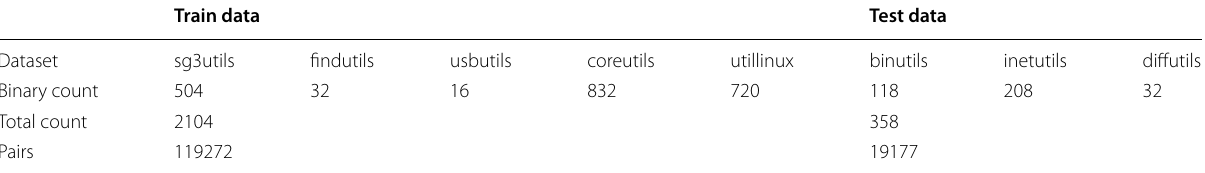
Table 6 A dataset for evaluating the impact of each component of the UPPC on semantic classification